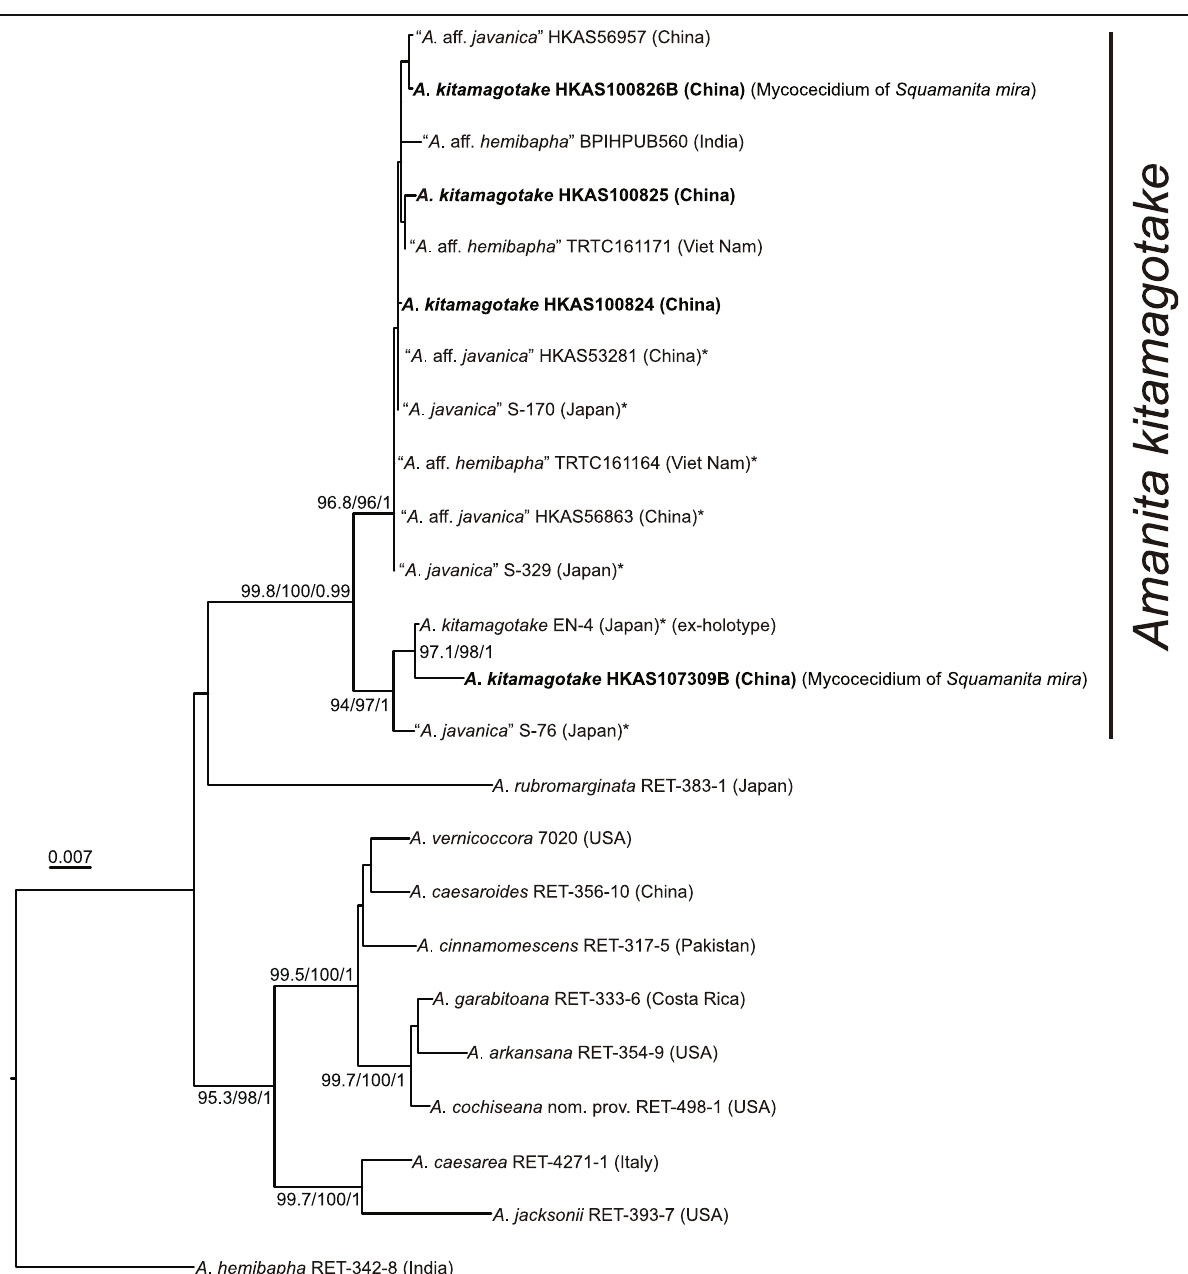
Fig. 4 Maximum-Likelihood (ML) phylogenetic tree inferred from the ITS-nrLSU-TEF1 - α dataset for detecting the phylogenetic relationships of the mycocecidia (hosts) of Squamanita mira and two specimens (HKAS100824 and HKAS100825) of Amanita kitamagotake collected near to S. mira (these four specimens are highlighted in boldface), with SH-aLRT (left), ultrafast bootstrap (UFB) (middle), and PPs values (right) near by the corresponding node. Only one of SH-aLRT > 80 or UFB > 95 for ML and PPs > 0.90 for BI are indicated along branches (SH-aLRT/UFB/PP). The sequences which were regarded as A . kitamagotake in Endo et al. (2017) are marked by asterisks